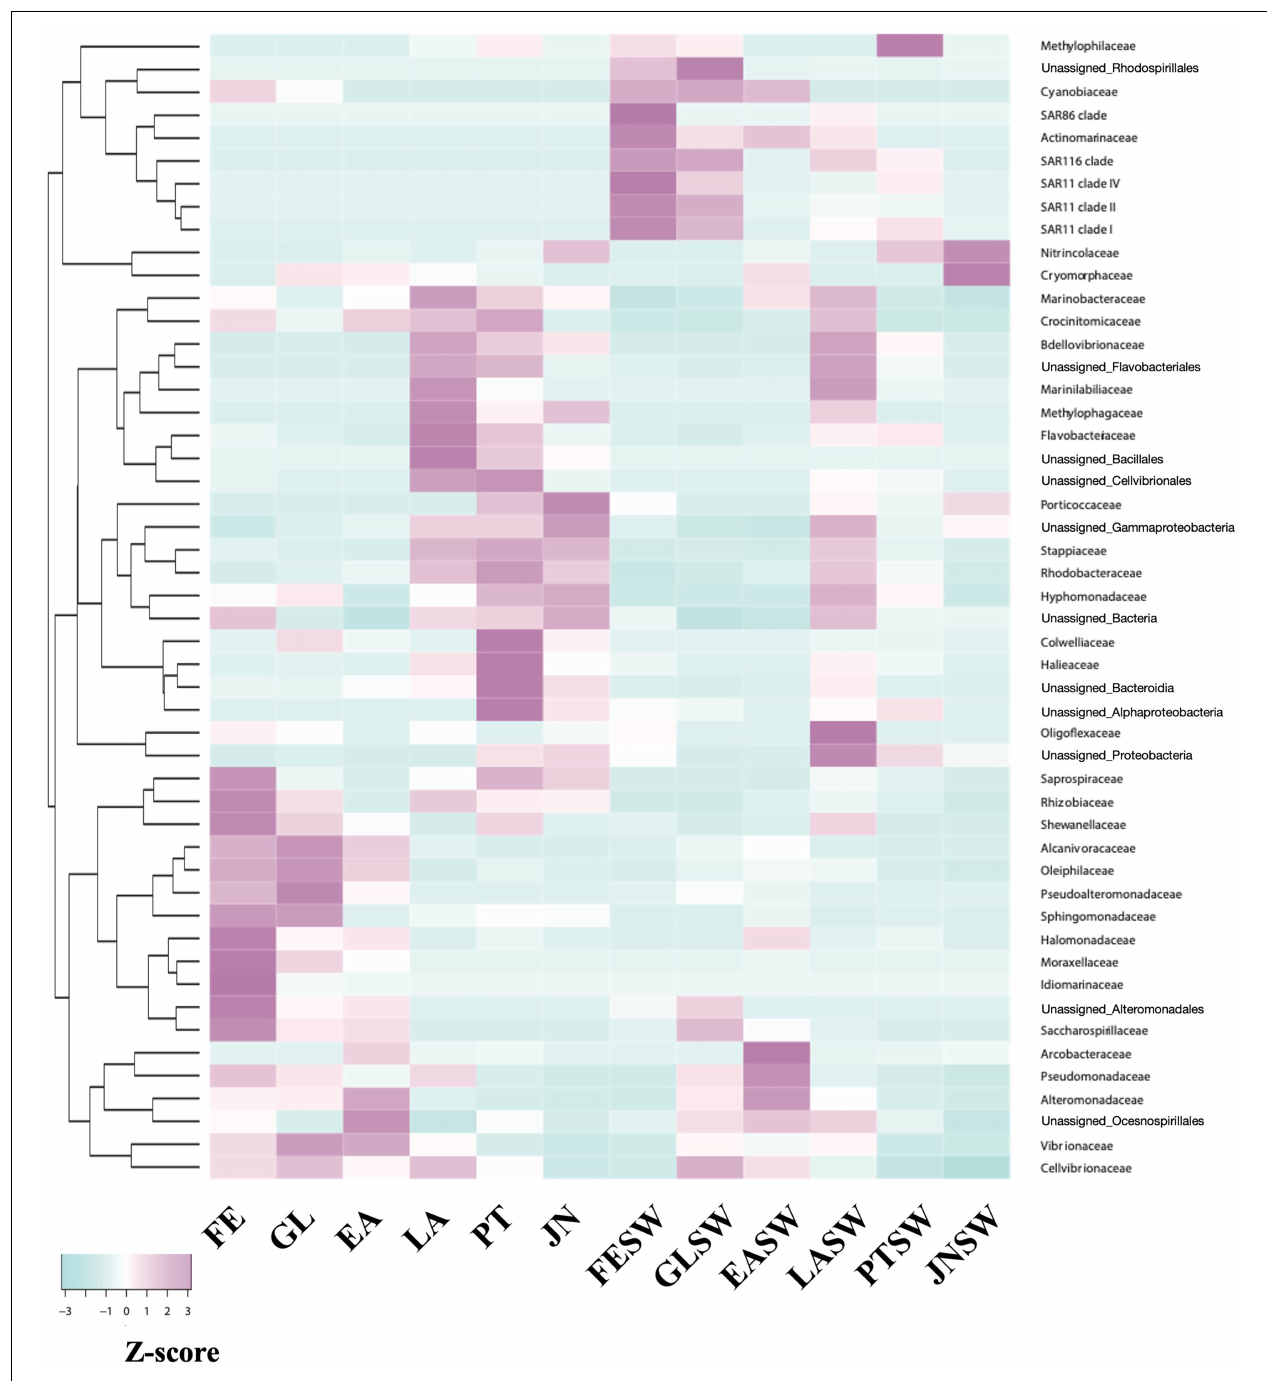
FIGURE 5 | Dynamics of signature families at each stage. Scale represents relative abundance after Z -score calculation. FE, Fertilized egg; GL, Gastrula; EA, Early auricularia; LA, Late auricularia; PT, Pentactula; JN, Juvenile; FESW, Fertilized egg rearing seawater; GLSW, Gastrula rearing seawater; EASW, Early auricularia rearing seawater; LASW, Late auricularia rearing seawater; PTSW, Pentactula rearing seawater; JNSW, Juvenile rearing